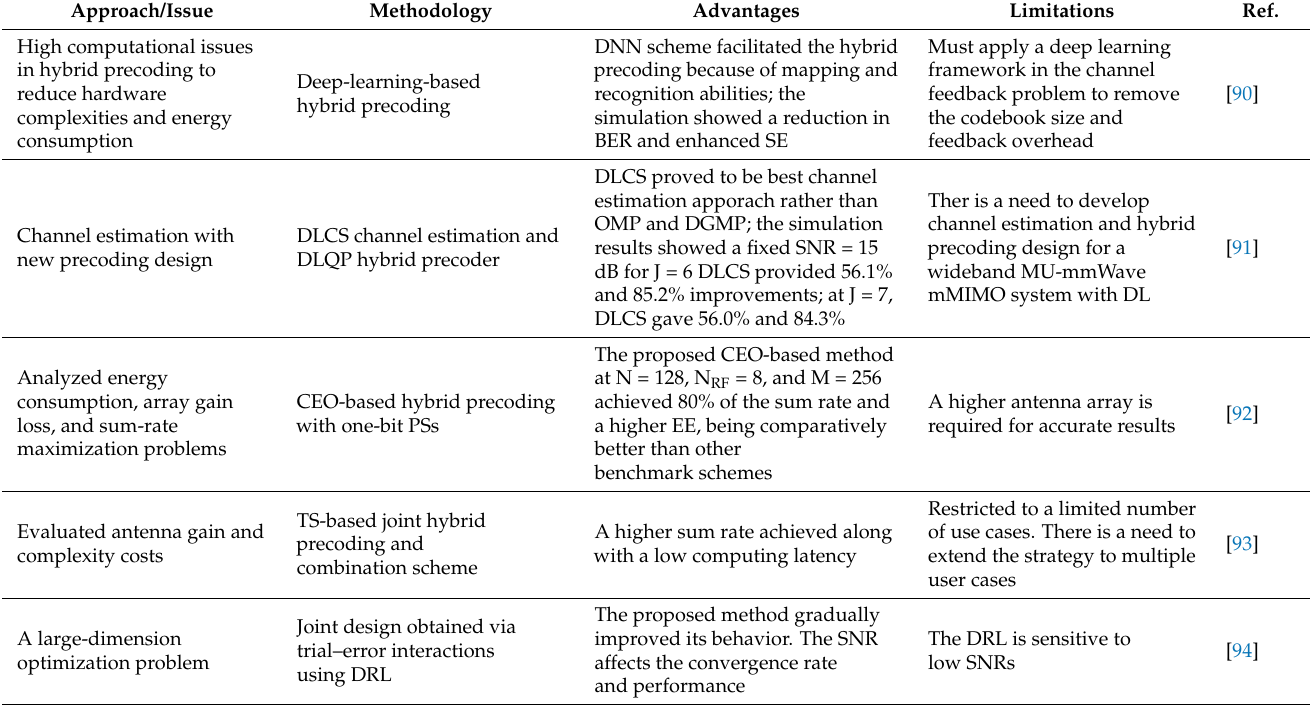
Table 4. Summary of hybrid precoding designs in BF-mmWave-mMIMO systems with